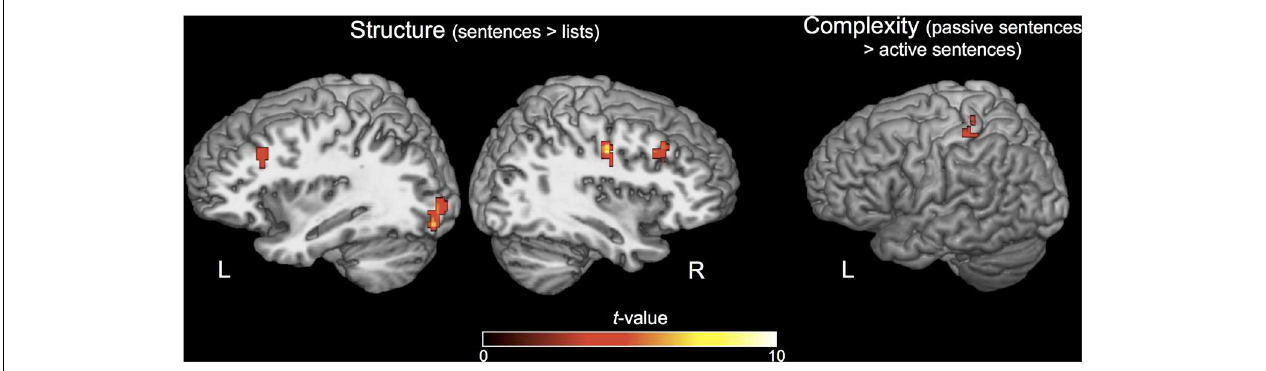
FIGURE 4 | Activations for the STRUCTURE and COMPLEXITY contrasts. N = 20. Activations are displayed on a Talairach template brain and cluster-corrected for multiple comparisons at FWE p < 0.05, individual voxel threshold p < 0.001 (one-tailed), cluster size threshold 610 mm 3 .